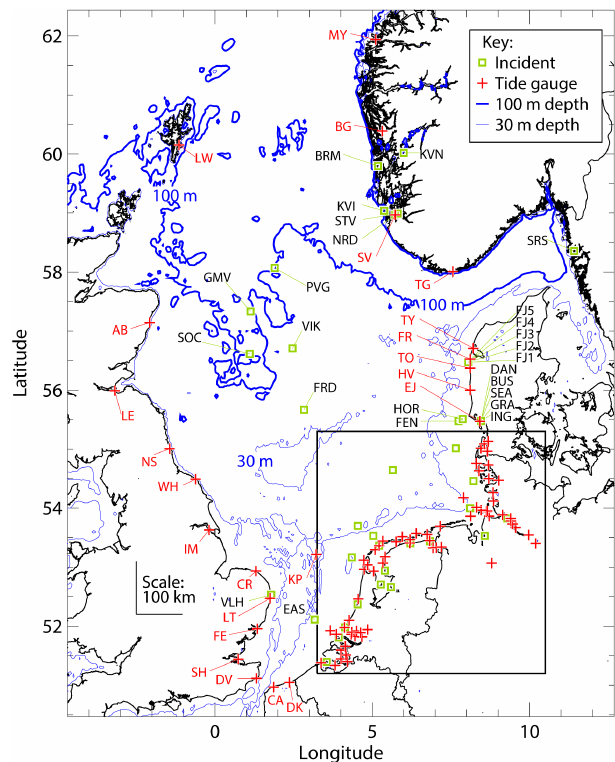
Figure 2. Location of tide gauges analyzed in this study and of North Sea maritime incidents that were reported over the period 26 November–5 December 1999. For presentation clarity, the in- formation in the inset box covering the south eastern North Sea is shown in Fig. 3. The abbreviation codes for the tide gauges and maritime incidents are explained in Tables S2 and